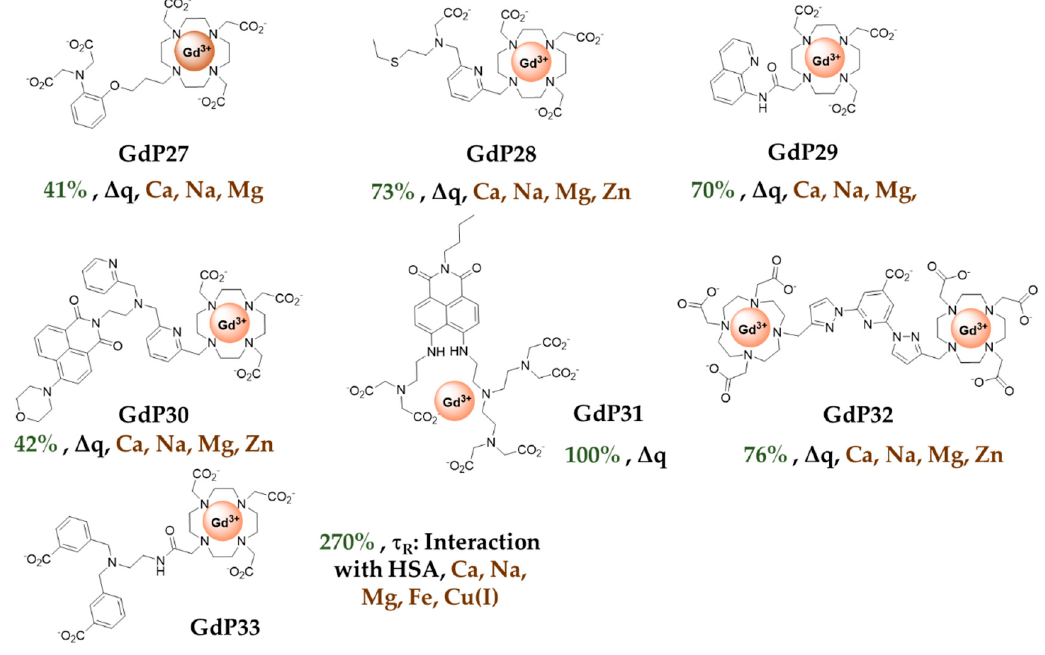
Figure 7. CopperresponsiveMRIcontrastagents: Ingreen(maximum ∆ r 1 ), black(mechanismofresponse), Figure 7. Copper responsive MRI contrast agents: In green (maximum Δ r 1 ), black (mechanism of brown (type of Cu 2 + response and response), brown (type of Cu 2+ response and selectivity).